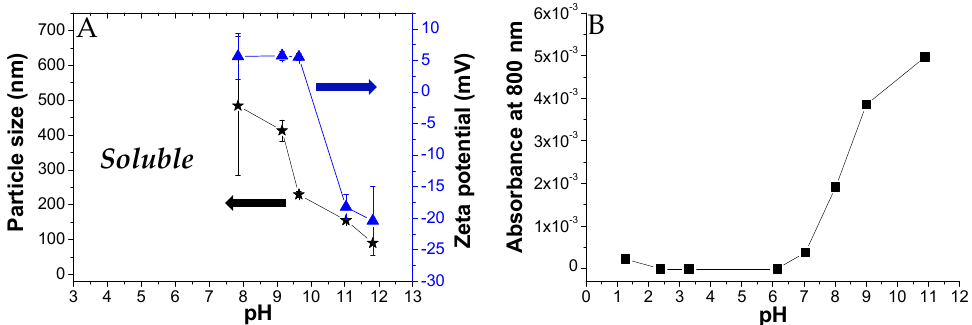
Figure 3. Size and zeta potential ( A ) and absorbance ( B ) of PKHEDA solutions at a concentration of 1 × 10 ⁻ 4 M of functional groups at different pH values.